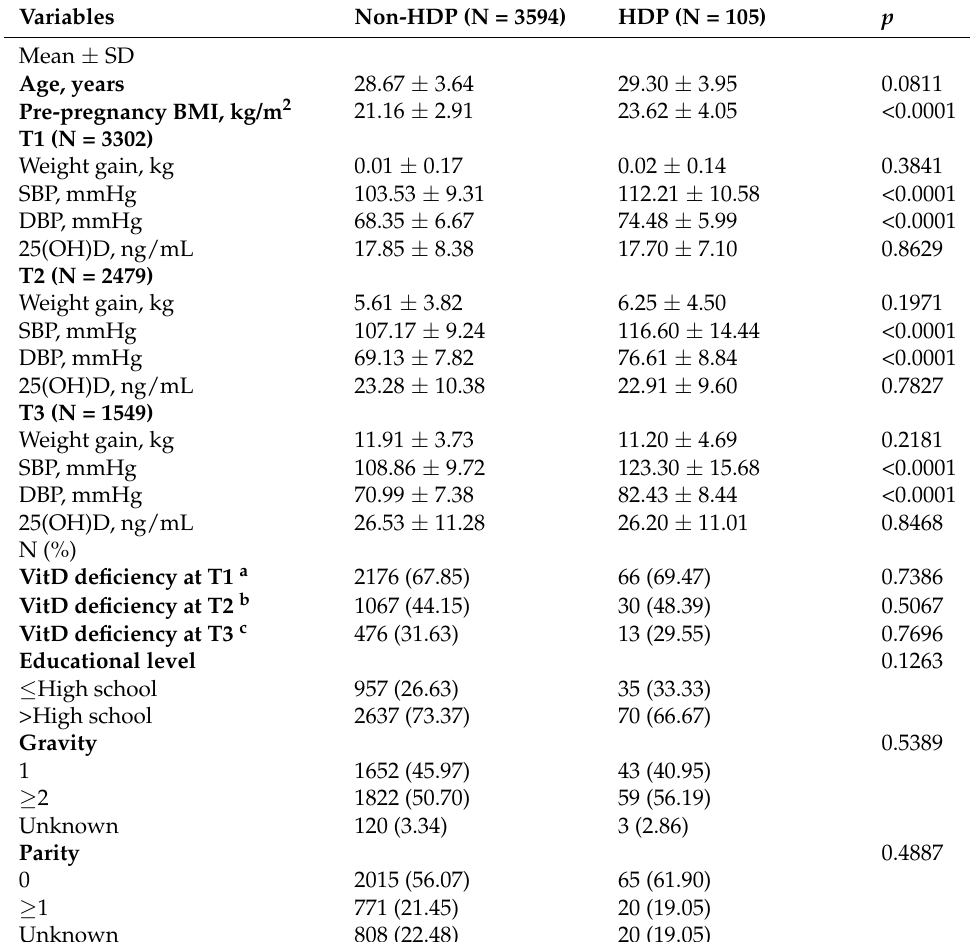
Table 1. Baseline characteristics of pregnant